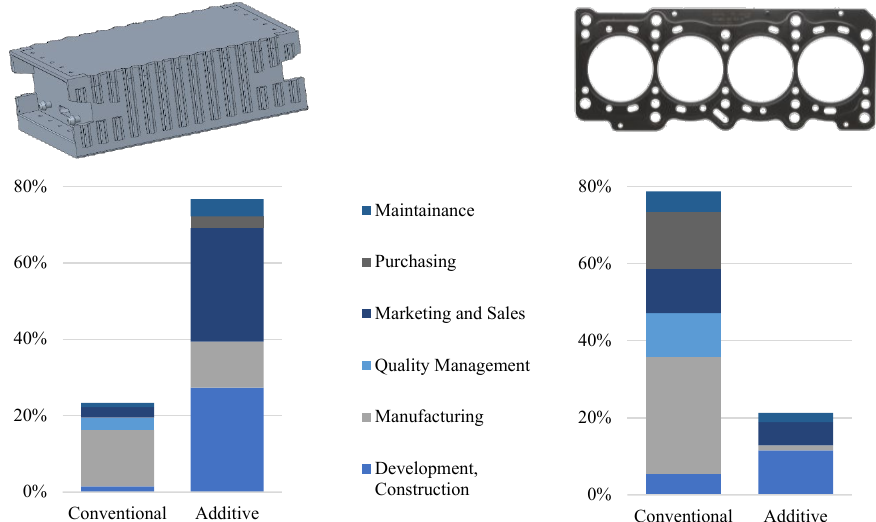
Figure 6. Comparison of the results of the AHP for the control unit housing and the flat metal Gasket.